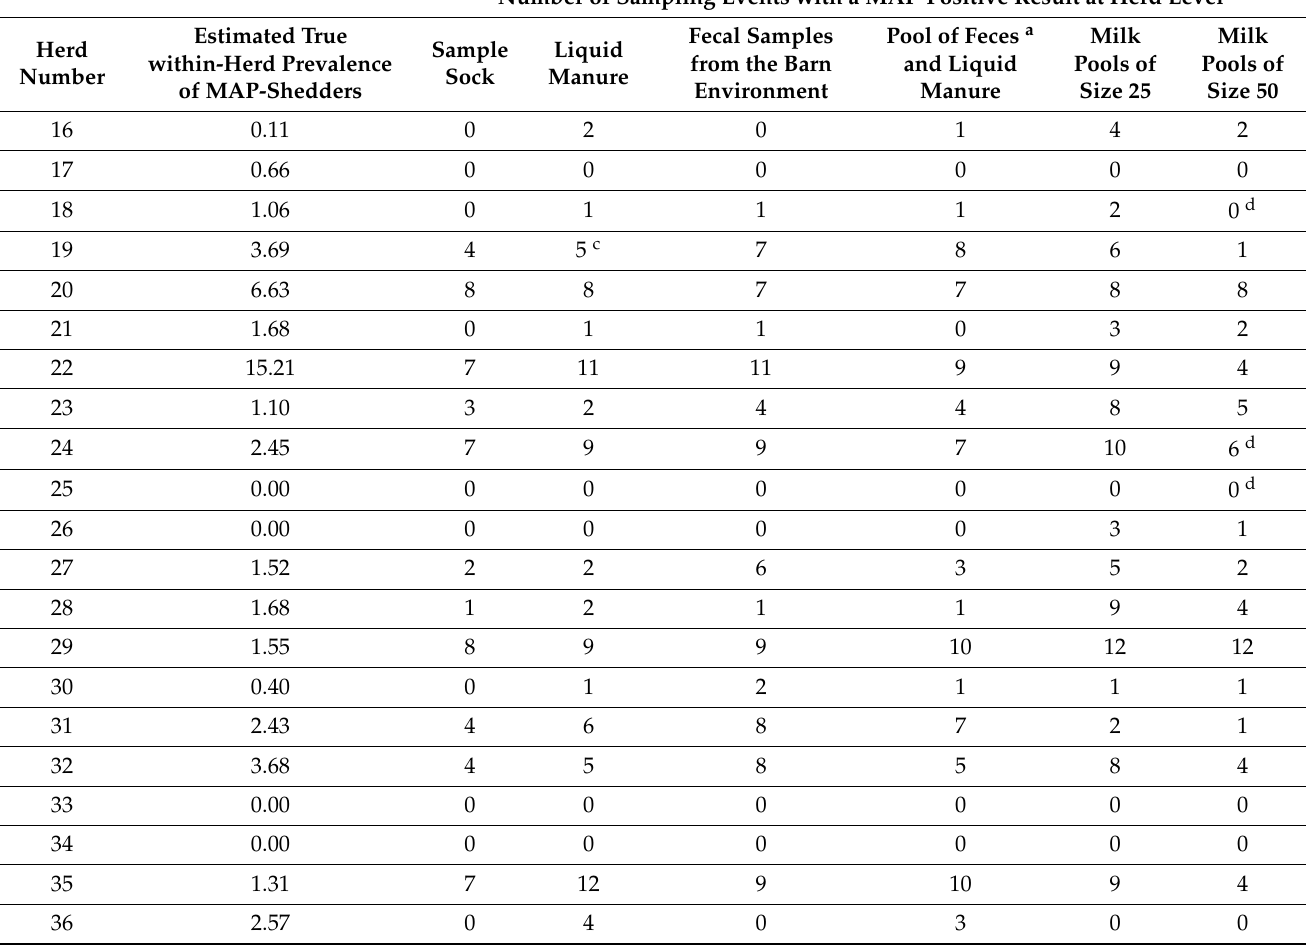
Table A1. Cont. Number of Sampling Events with a MAP-Positive Result at Herd